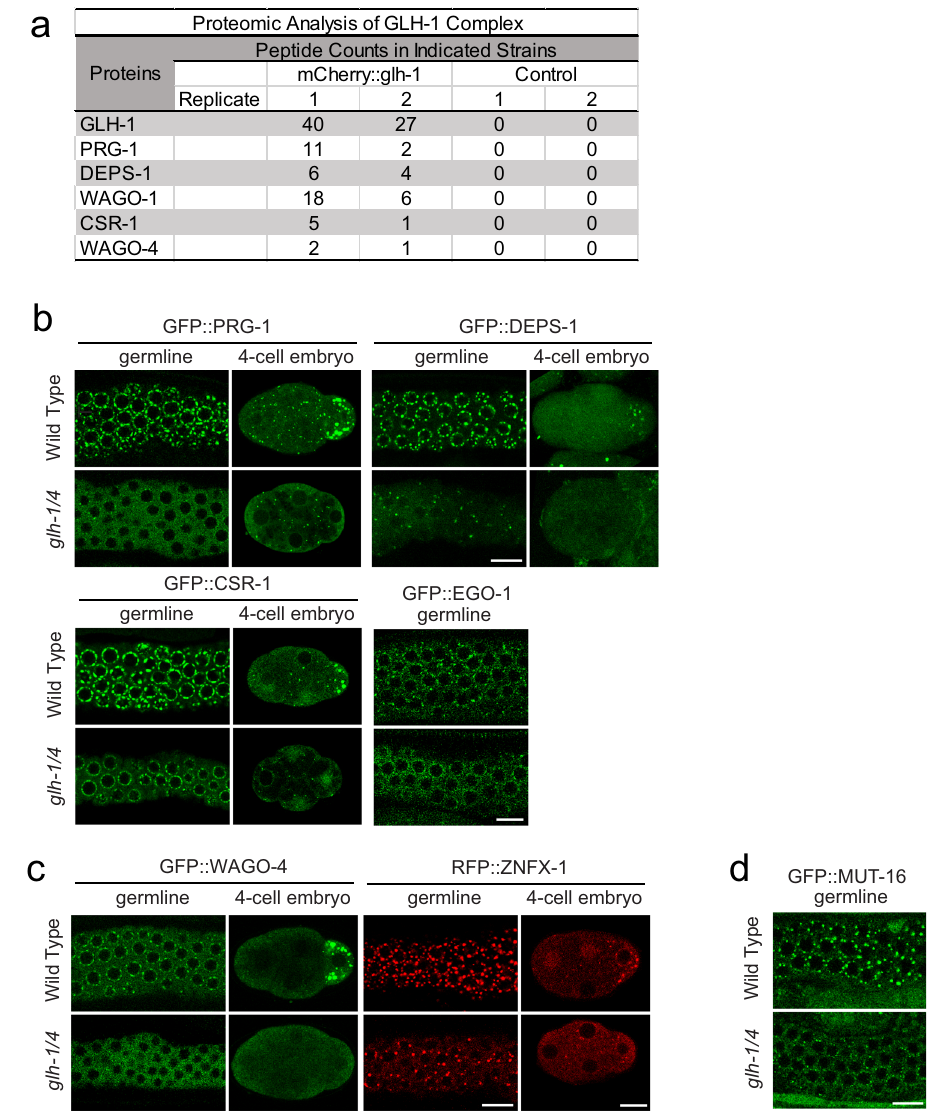
c Fluorescent micrographs show the localization of the speci fi c proteins known to be enriched in Z granules in the wild type or the glh-1 glh-4 mutant in the adult germline (left) and in the four-cell embryo (right). Bar, 10 micrometers. d Fluorescent micrographs showthe localization ofthe speci fi c proteins known to be enriched in mutator granules in the wild type or the glh-1 glh-4 mutant in the adult germline. Bar, 10